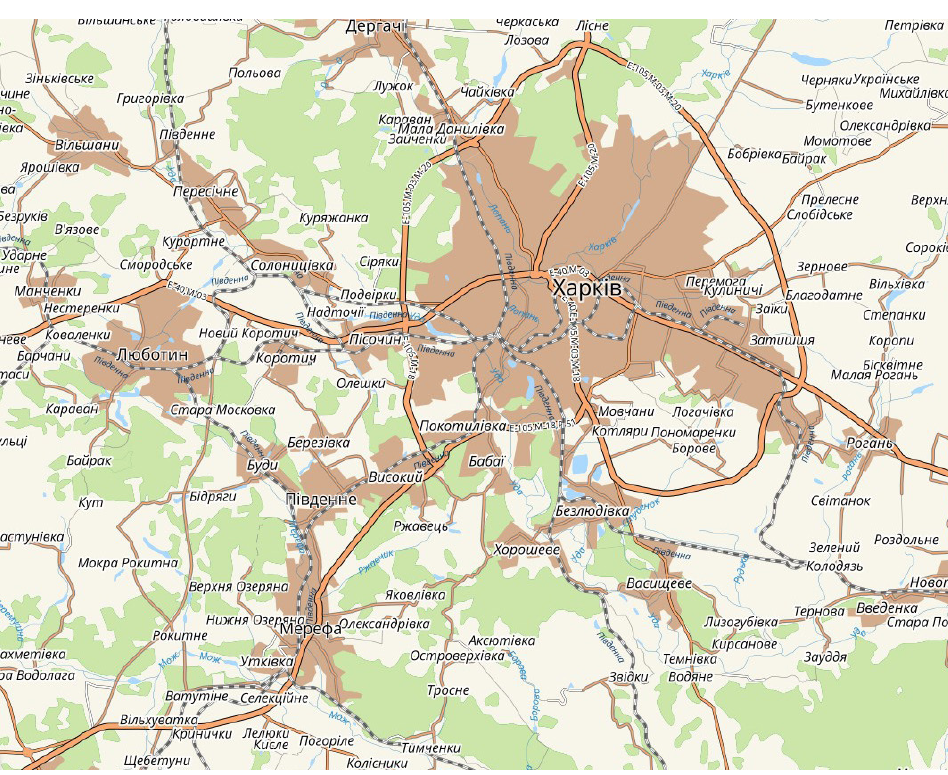
Fig.1. The Digital Topographic Map of Ukraine at a scale of 1:100,000 (reduced); https://dgm.gki.com.ua/map/shema-dgm#map=6//47.98256841921405//32.01416015625001&&layer=181154